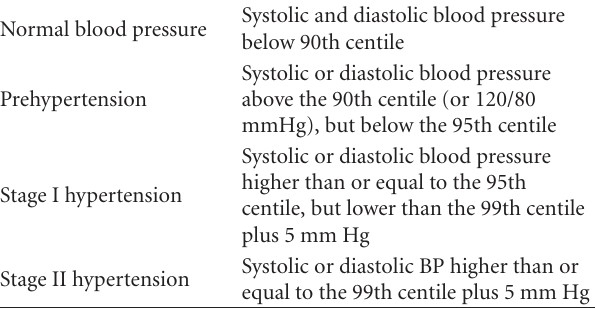
Table 1: Definitions of normal and elevated blood pressure in children.